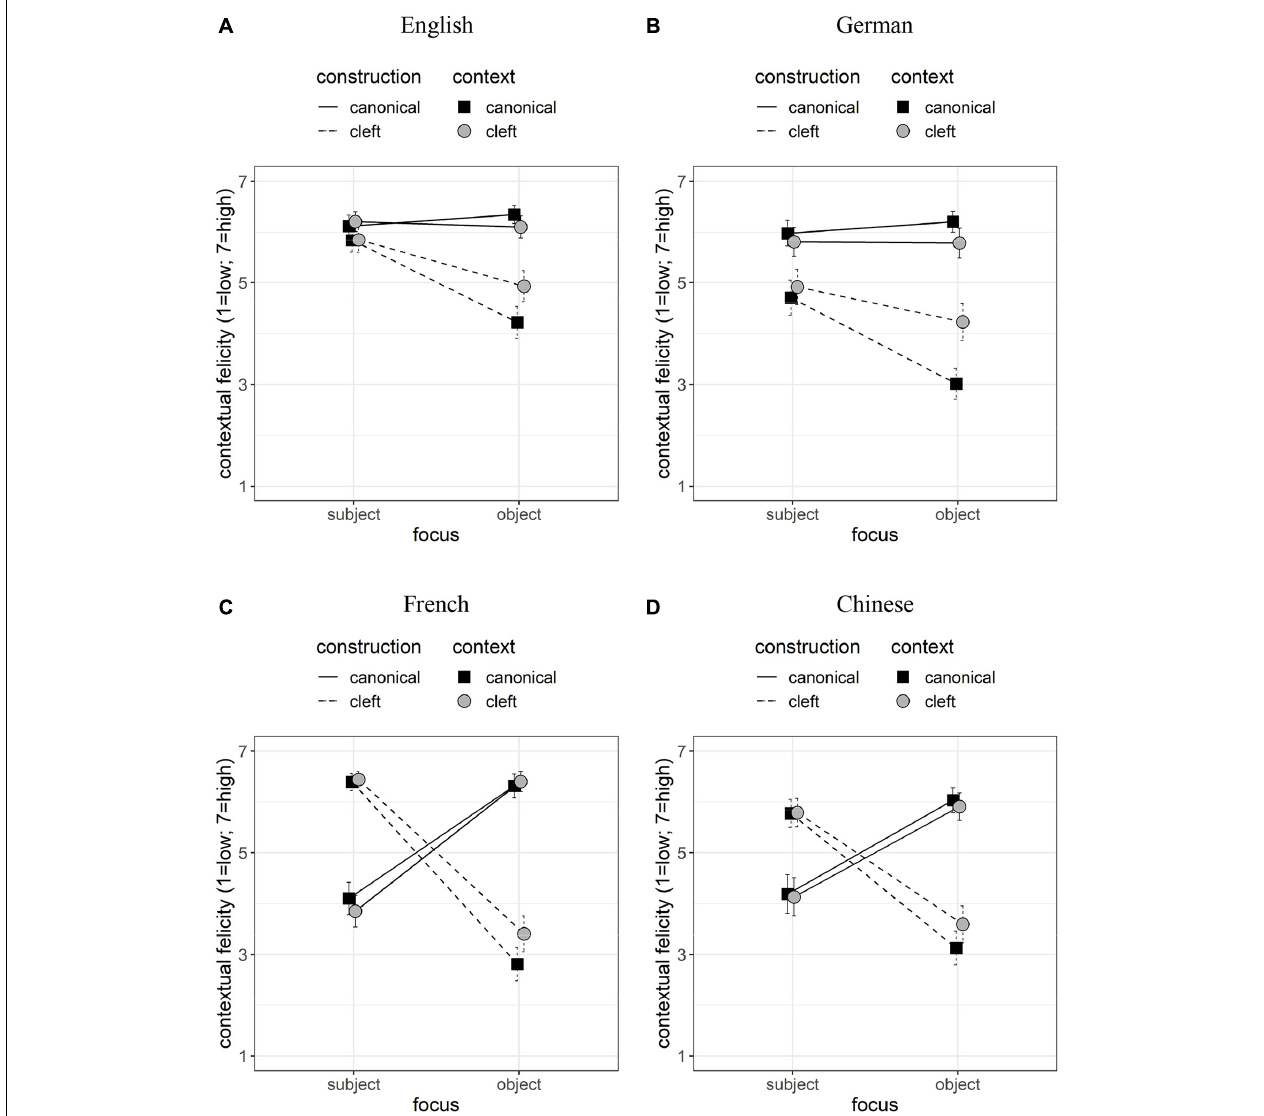
FIGURE 7 | (A–D) Contextual felicity (Y-bars: confidence intervals with probability